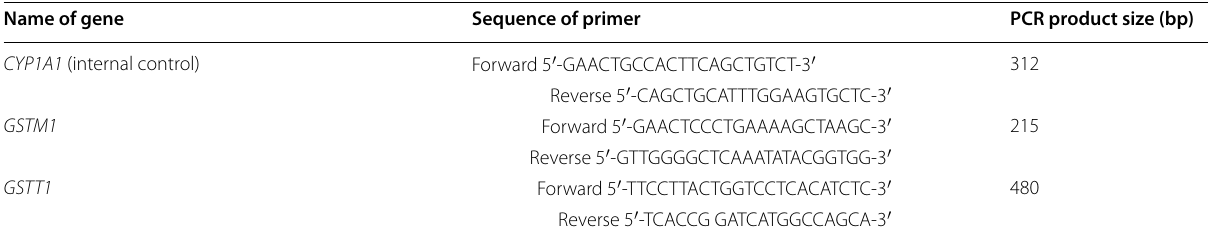
Table 1 GSTM1 and GSTT1 gene’s primer sequences Name of